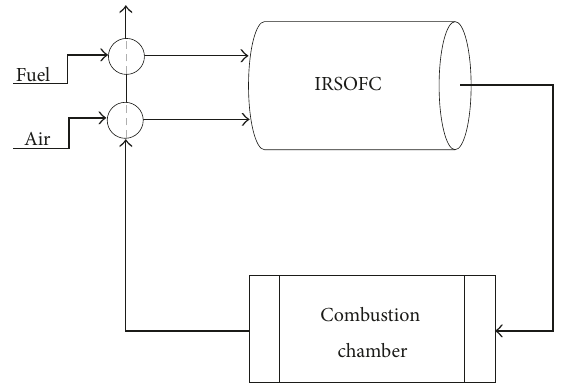
Figure 7: A schematic of the IRSOFC cycle.